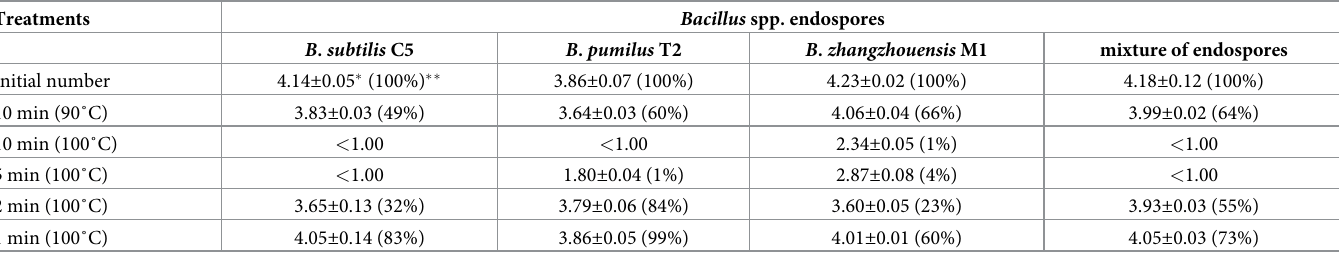
Table 2. Effect of different temperature/time combinations on endospores inoculated in Tilia tomentosa extract. Treatments